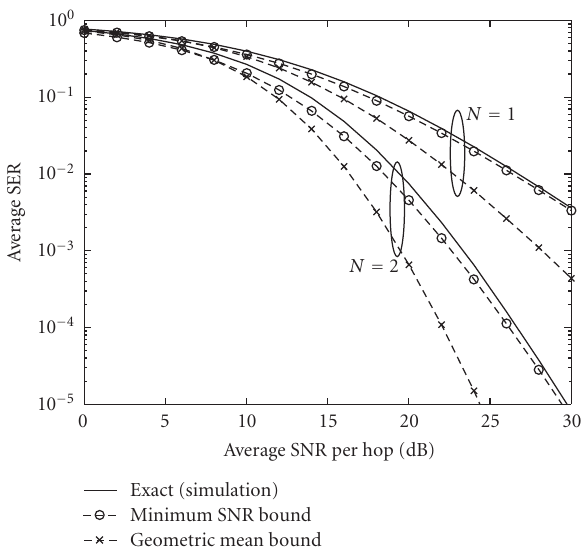
Figure 3: Average SER for 16-QAM versus average SNR per hop for N = 1 and N = 2 dual-hop links with MRC assuming m 0 = 1, k 0 = 0 . 5 for the direct link, m 1 = 1, k 1 = 1 . 5 for the first relay link, and m 2 = 2, k 2 = 3 for the second relay